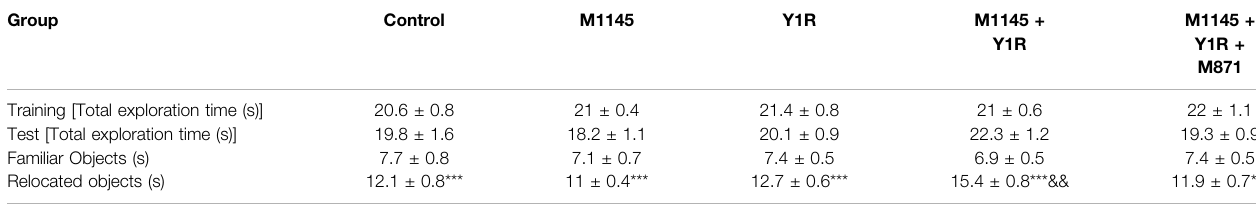
TABLE 1 | Exploratory activity of rats treated with Galanin 2 receptor agonist (M1145) and the Neuropeptide Y Y1 receptor (NPY Y1)agonist alone and in combination. Data are expressed as mean ± SEM from the training and test sessions during the Object-in-place task. For total exploration time in training and test sessions no statistically signi fi cantdifferencewasobservedbetweentheexperimental groupsaccordingtoonewayANOVA.&& p < 0.01accordingtoone-wayANOVAfollowedbyNewman-Keuls post-hoc test for relocated objects time of M1145 + Y1R group compared with the rest of the groups. *** p < 0.001 (two-tailed paired t -test) Familiar vs. Relocated.